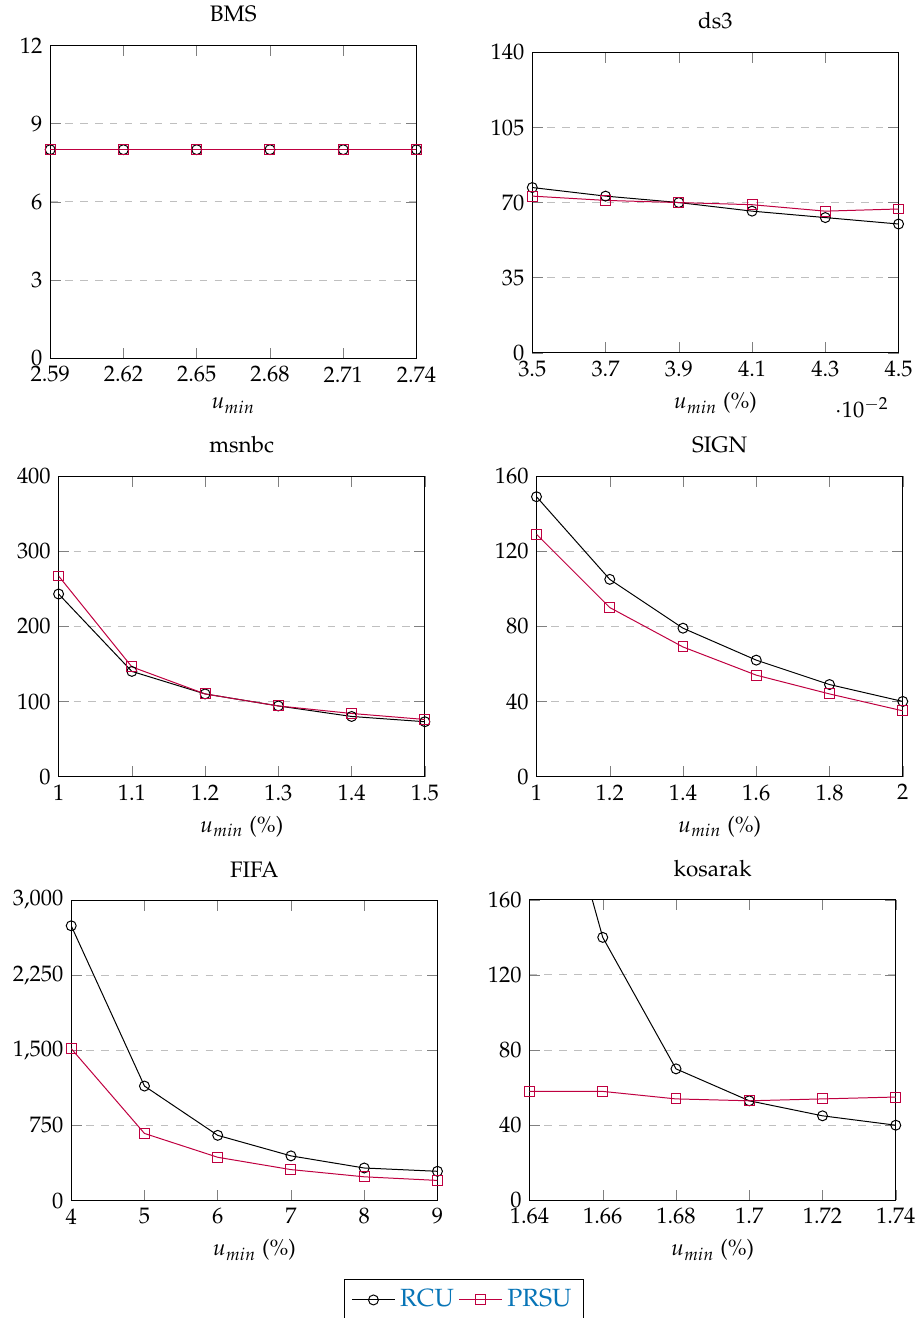
Figure 11. Results of experiment 2: Time (s) taken by each of the RCU and PRSU methods to identify the full set of high utility sequential